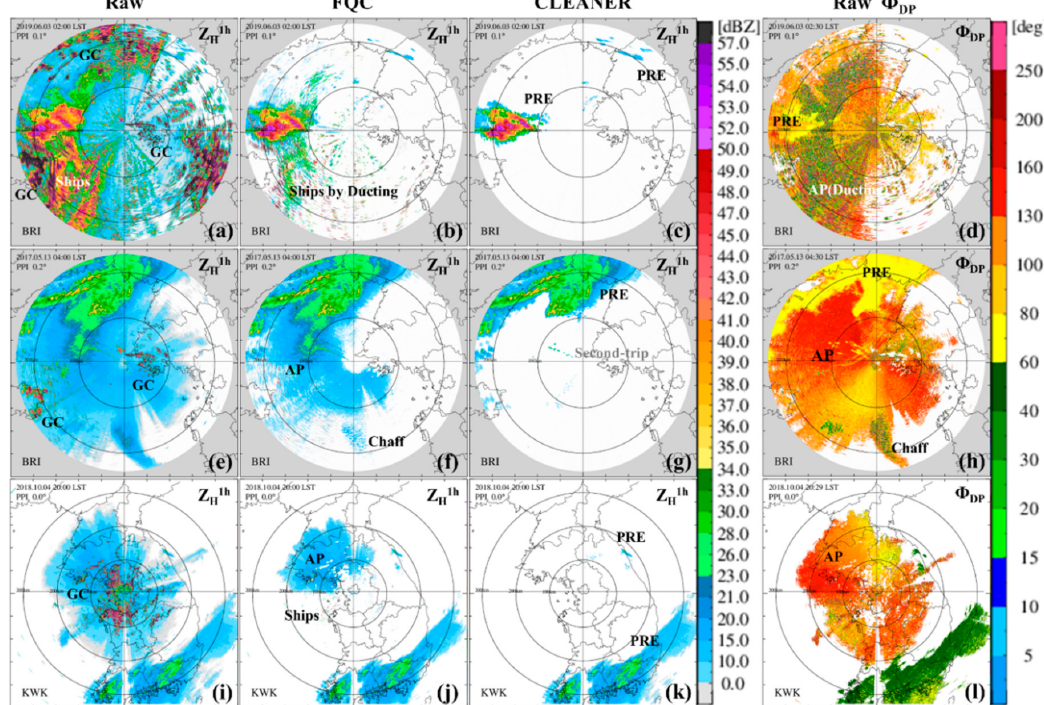
Figure 9. As in Figure 8, but with the di ff erential phase field for the anomalous propagation cases with PRE ( a – d ) in ducting collected by BRI at an elevation angle of 0.1 ◦ from 0200 to 0255 LST 3 June 2019 (top), in super refraction collected ( e – h ) by BRI at an elevation angle of 0.2 ◦ from 0400 to 0455 LST 13 May 2017 (middle), and ( i – l ) by KWK at an elevation angle of 0.0 ◦ from 2000 to 2055 LST 4 October 2020 (bottom).